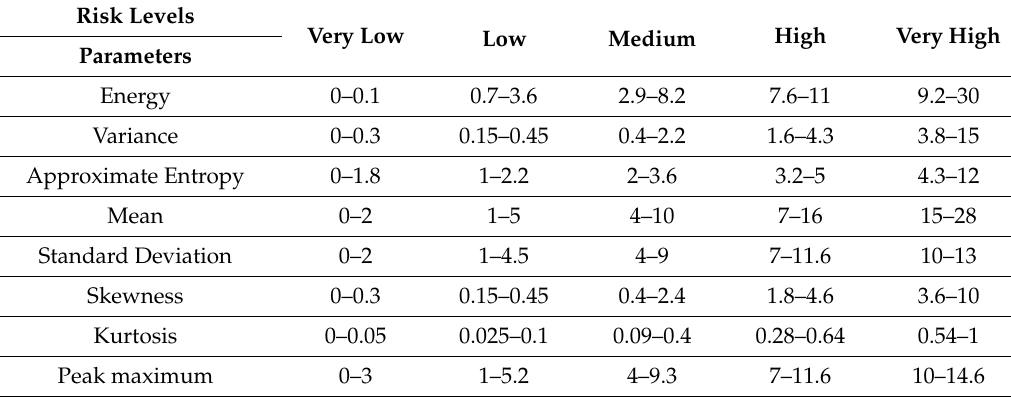
Table 3. Parameter ranges for various risk levels for fuzzy linguistic sets.